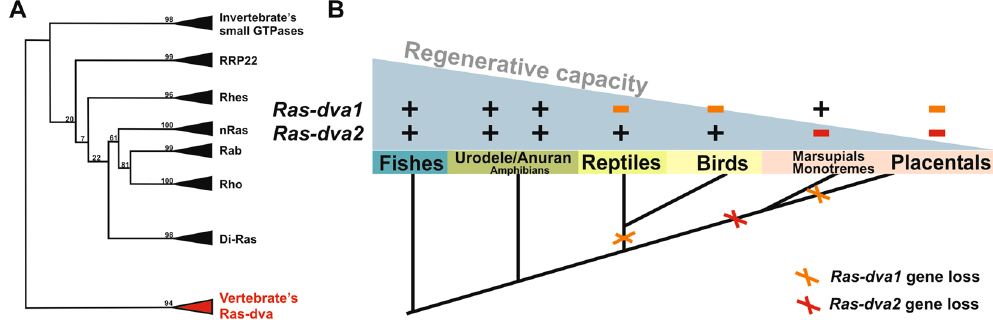
Figure 1. Genes of Ras-dva family of small GTPases were eliminated during vertebrates’ evolution. ( A ) Schematic version of the phylogenetic tree (full version see at Supplementary Fig. S1) of Ras-dva small GTPases and nearest groups of small GTPases, Ras, Rho, Rab etc . All vertebrate’s Ras-dva proteins form a separate bunch (bootstrap 94). The nearest homologs (41% of homology) are invertebrate small GTPases. ( B ) Scheme of Ras- dva genes elimination during vertebrates’ evolution. The presence of Ras-dva1 or Ras-dva2 genes in different classes is marked by “plus”, absence - by “minus”. The gray triangle demonstrates the tendency of impairment in regenerative ability during the evolution. Oblique cross indicates the loss of Ras-dva1 or Ras-dva2 gene. Notably, lack of Ras-dva genes correlates with the regenerative capacity decrease. Drawings were done by